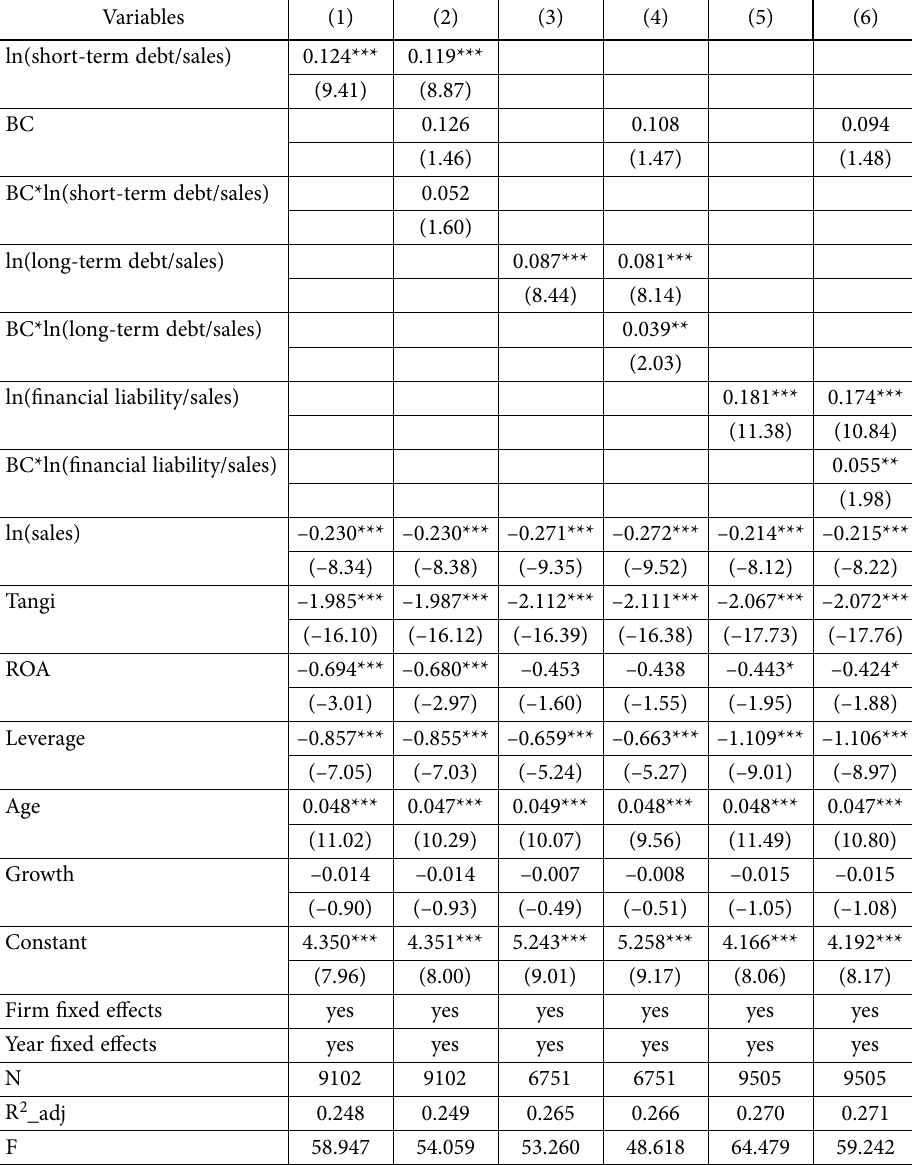
Table 4. Chinese non-financial firms: panel regressions of bank connections and firms’ shadow banking behaviour (2003–2016)